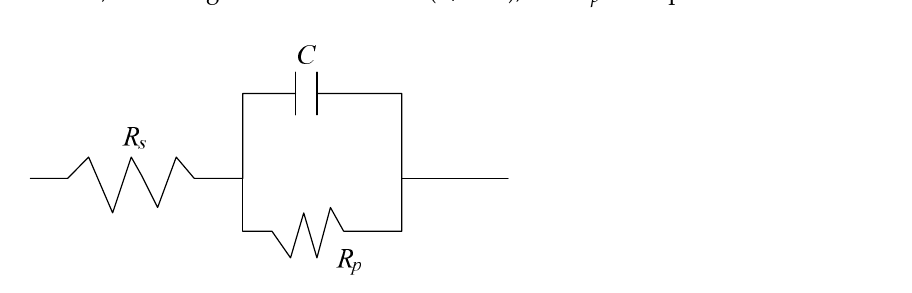
Table 6. Component values of equivalent circuit